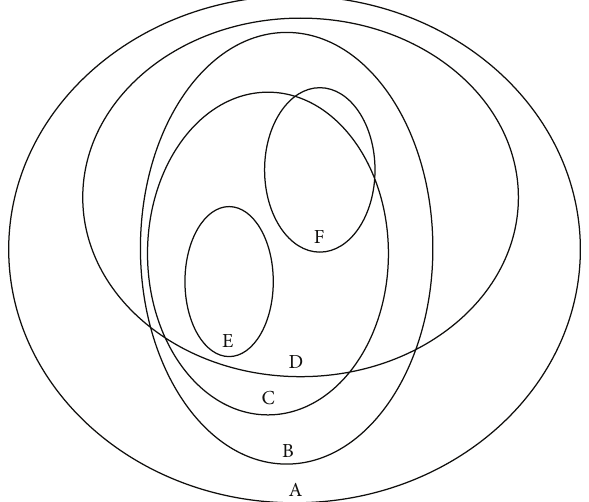
Figure 1: Inclusion relationships among classes of completely mon- otonic and related functions on (0, ∞) . (A) Almost completely monotonicfunctionclass.(B)Completelymonotonicfunctionclass. (C) Logarithmically completely monotonic function class. (D) Almost strongly completely monotonic function class. (E) Strongly logarithmically completely monotonic function class. (F) Strongly completely monotonic function